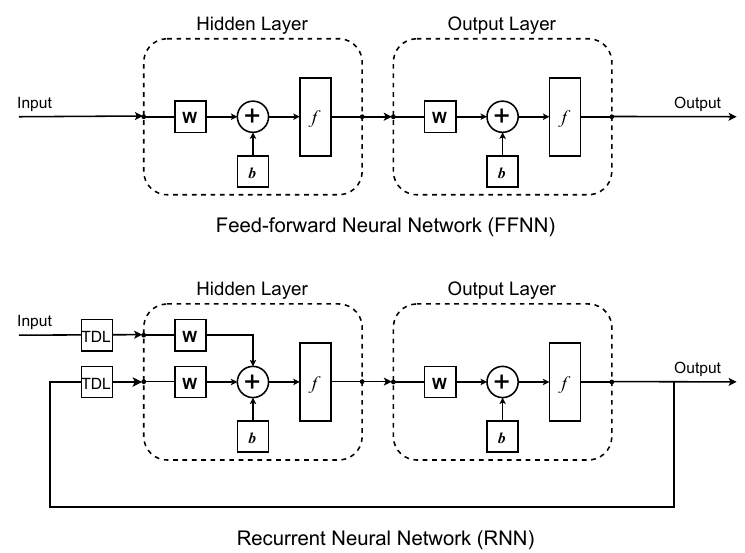
Figure 2. Comparison of neural network architecture between FFNN and